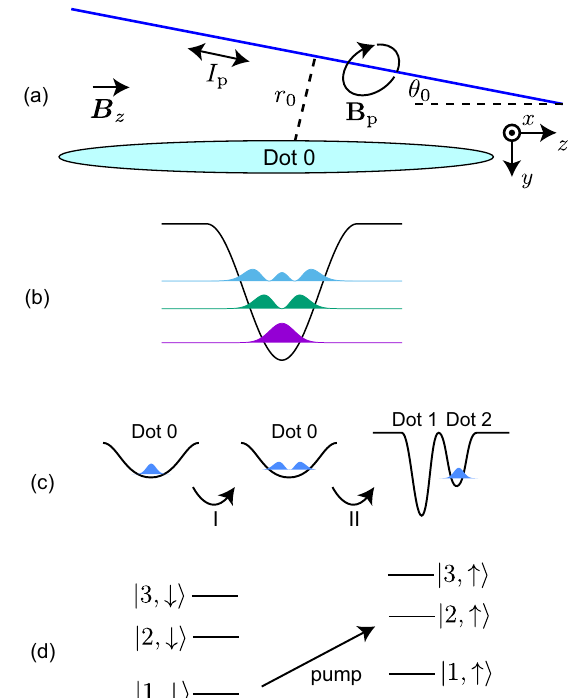
Figure 1. ( a ) Proposed system. The blue line represents the conducting lead carrying the AC control current I p producing the magnetic field (pump field) B p = ( B p ,0,0 ) perpendicular to the surface. The conducting lead is tilted with respect to the z -axis by angle θ 0 . Here, r 0 is the distance of the lead from the center of Dot 0. The generated AC magnetic field couples the ground state and the first excited state in the dot. ( b ) Colors show the square of the amplitude of the wave functions of the three lowest eigenstates with either spin-up or spin-down in Dot 0. The black curve is the schematic of the potential of Dot 0. ( c ) Schematics of the spin-selective electron transfer. The black curves depict the potential profile of quantum dot(s) at each step. The blue color represents the squared amplitude of the wave function of an electron whose initial spin was down. ( d ) Energy diagram of the system in Step I. Here, | i , ↑ ( ↓ ) (cid:105) is the i th instantaneous eigenstate of Dot 0 with spin-up (down). The pump field B p couples | 1, ↓(cid:105) and | 2, ↑(cid:105)